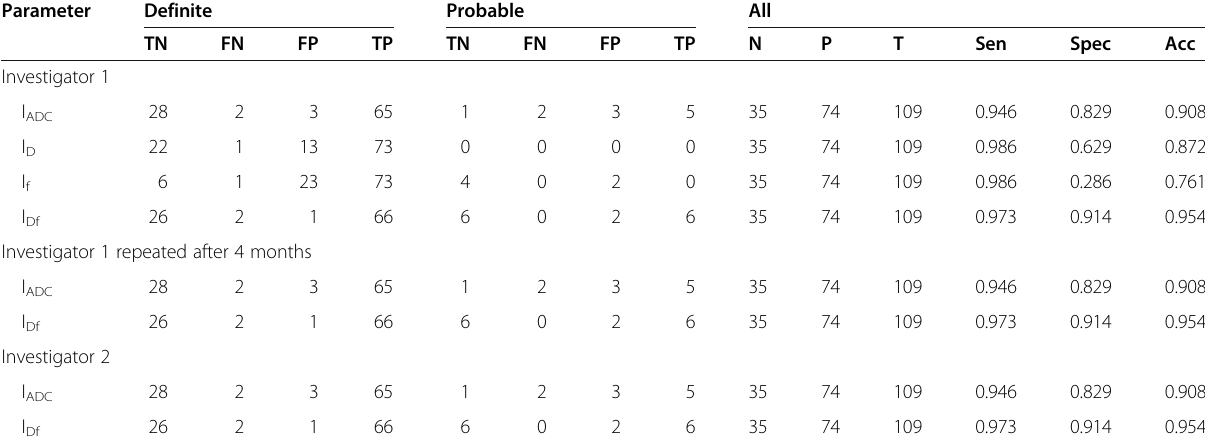
Table. 5 Results of visual judgment of index maps I ADC , I D , I f , and combined I Df